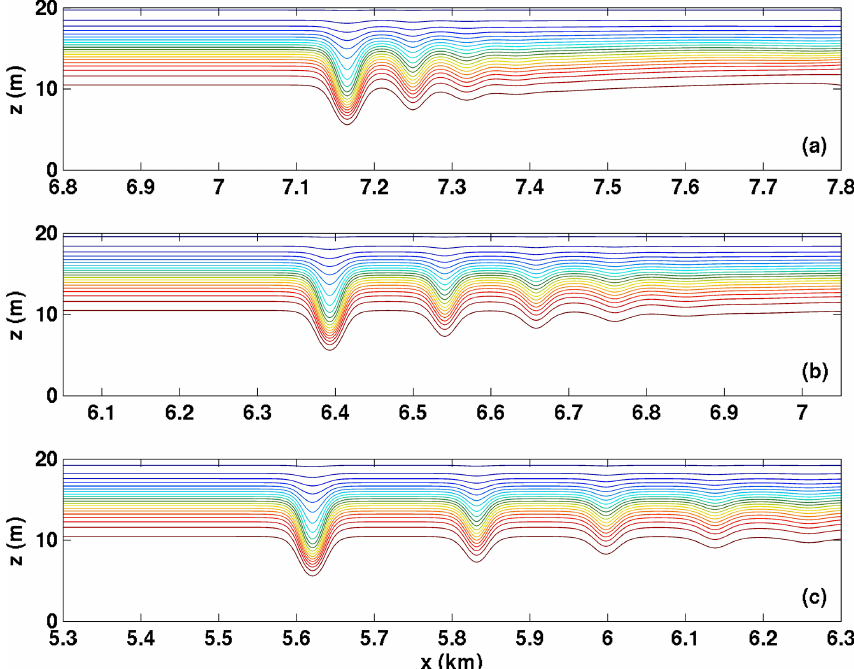
Figure 6. Density fields for wave trains propagating against the shear current for Case NO DJL 1. (a) t = 7200s, (b) t = 14400s, and (c) t = 21600s.